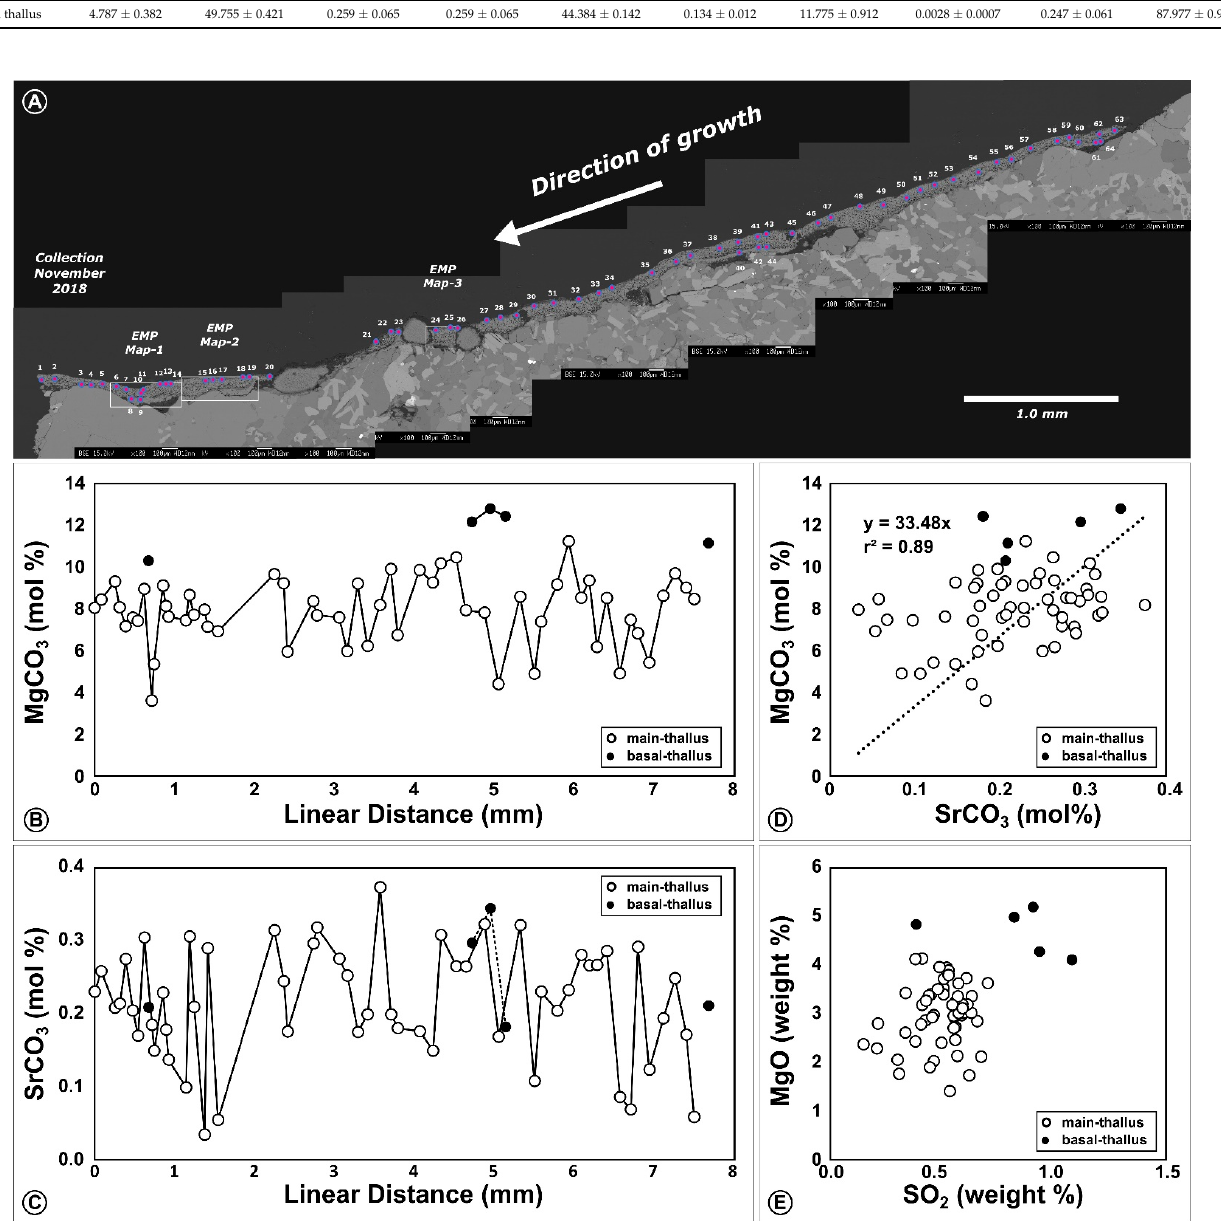
Figure 7. Overview ( A ) of the 7.5 mm long algal thallus section and the position of qualitative EMP- maps 1 to 3 and the quantitative EMP-spot measurements. Thallus growth direction is from right to left. Left margin was actively growing in November 2019. Quantitative EMP-spot measurements in the main thallus run along an ontogenetic transect from left (TNB-1) to right (TNB-64). ( B ) Quanti- tative EMP spot-measurements of MgCO 3 (mol%). ( C ) Quantitative EMP spot-measurements of SrCO 3 (mol%). ( D ) Relation of MgCO 3 (mol%) and SrCO 3 (mol%) from quantitative EMP spot-meas- urements. ( E ) Relation of MgO (weight%) and SO 2 (weight%) from quantitative EMP spot-measure- ments. Table 2. Summarized quantitative EMP-spot measurements of the basal thallus (n = 5) and the main thallus (n = 55).